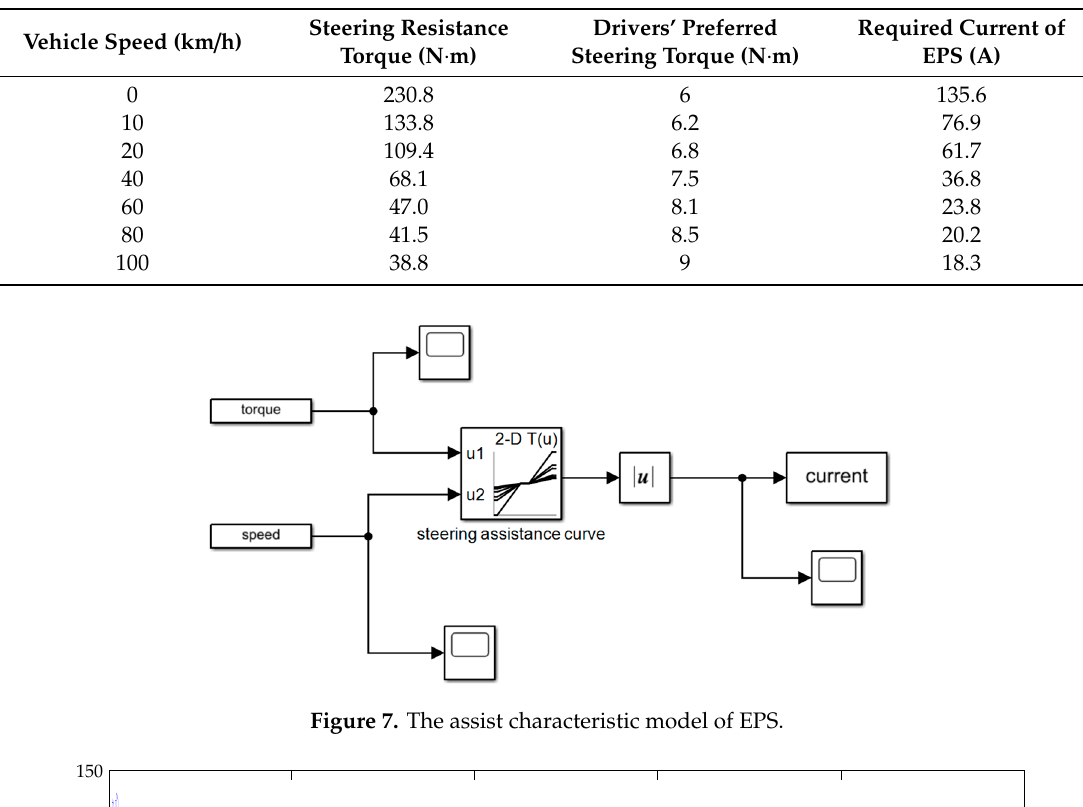
Table 3. The required current of EPS at di ff erent vehicle speeds.